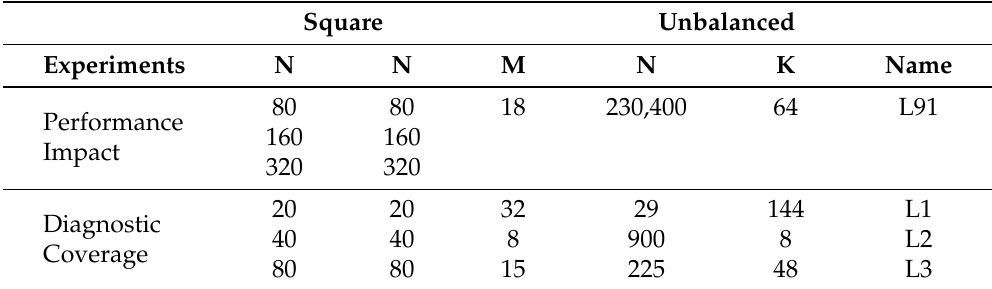
Table 2. Matrix dimensions employed in the